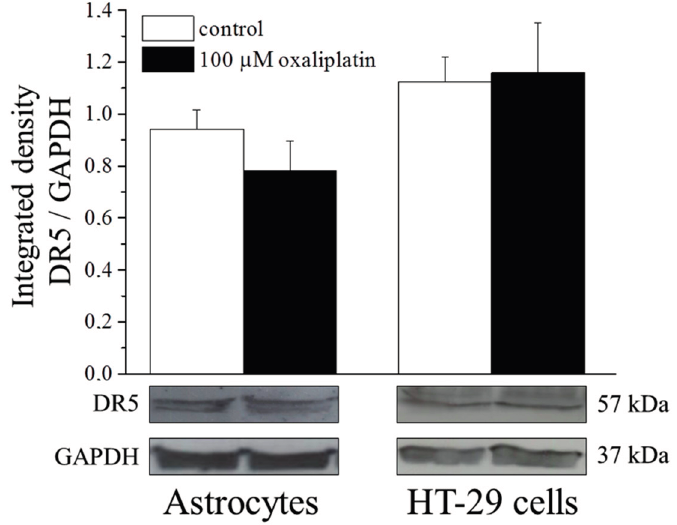
Figure 4. Death receptor 5 (DR5) protein expression. Astrocytes (10 6 cells/flask) and HT-29 (8 × 10 5 cells/flask) were incubated with 100 μ M oxaliplatin for 8 h and then Western blot analysis were performed. Densitometric analysis ( top ) and representative immunoblot ( bottom ) are shown. GAPDH was used as loading control and GAPDH normalization was performed for each sample. Values are expressed as integrated density making the ratio between DR5 and GAPDH specific band intensities. Bars represent the mean ± S.E.M. of three